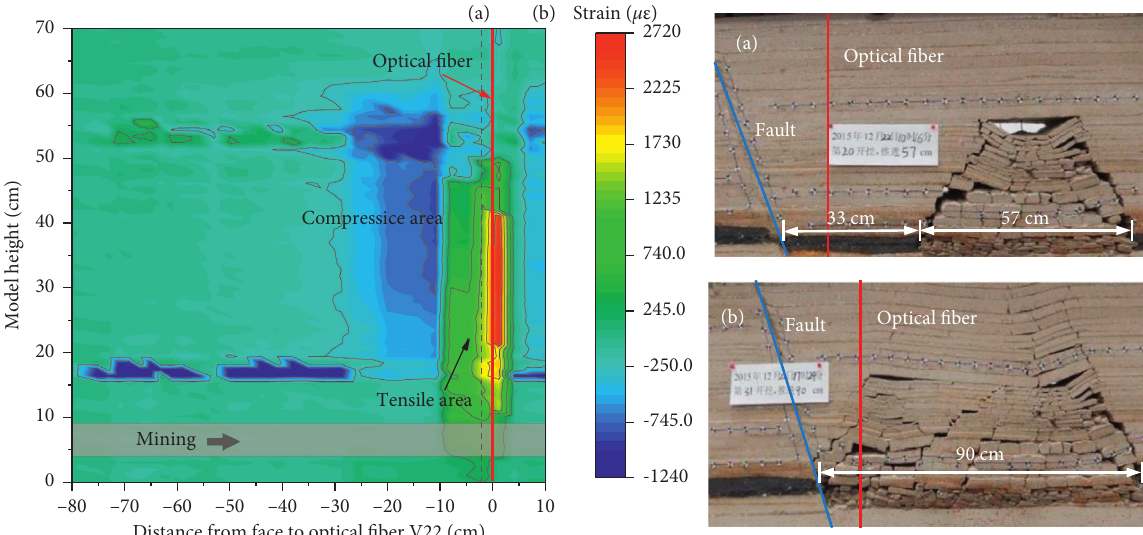
Figure 8: Fault strain evolution for mining faults in the upper disk of the